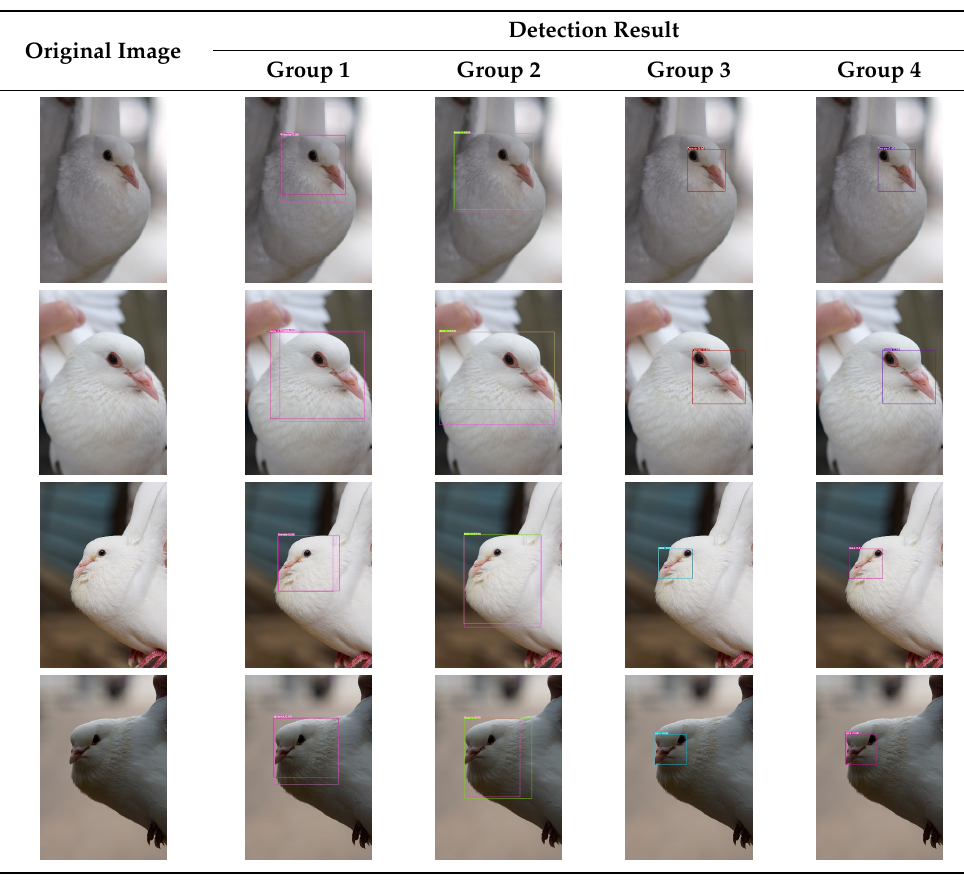
Table 2. Partial test results display of different models.